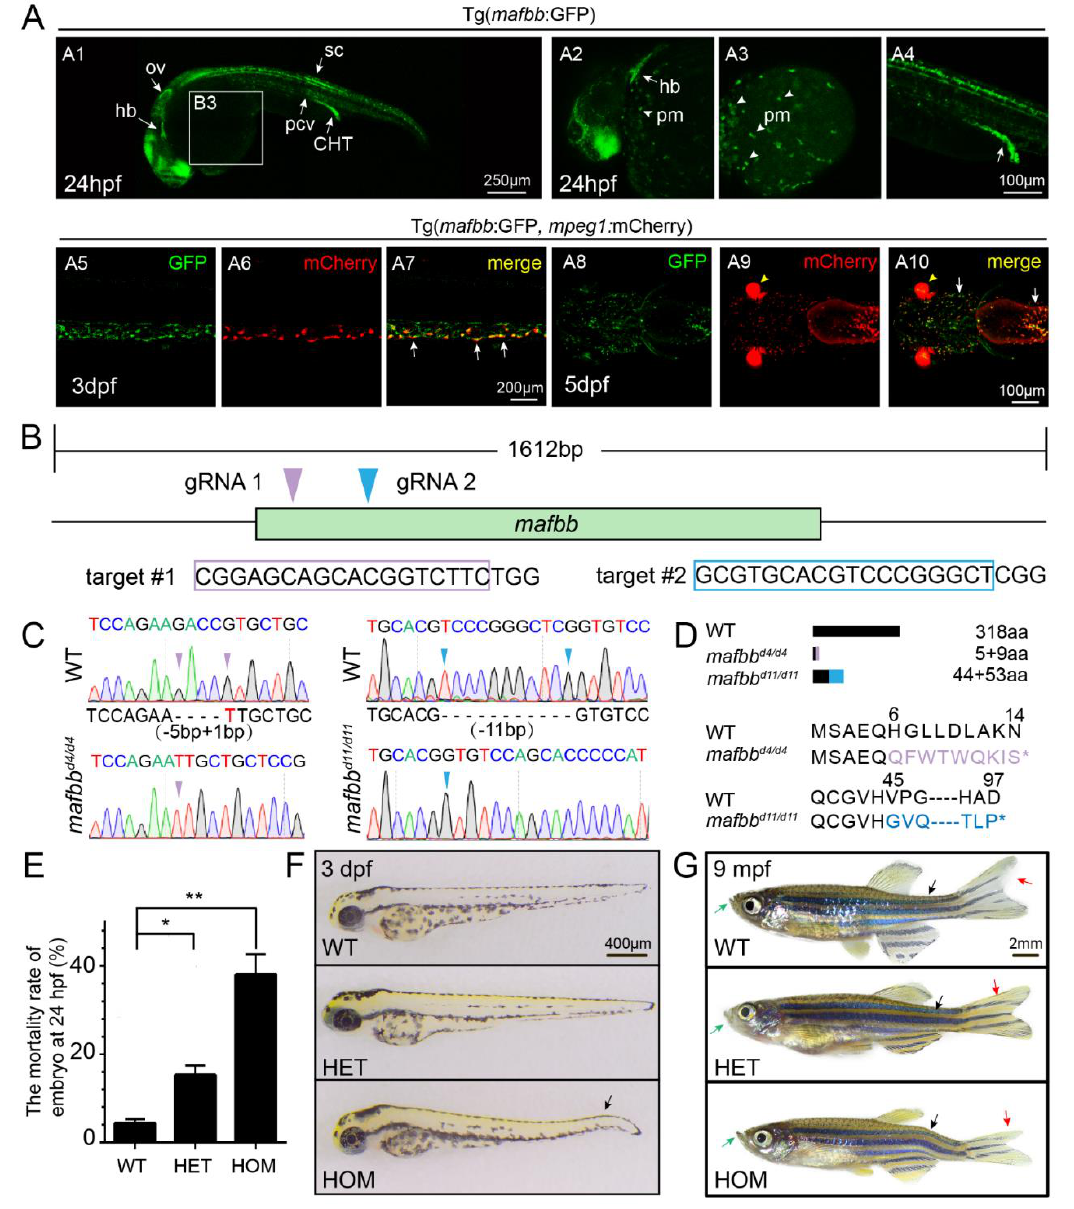
Figure 1. The expression of mafbb during embryogenesis and generation of mafbb mutants. ( A ) Tg ( mafbb :GFP) shows mafbb expression in primitive myeloid (pm) cells, hindbrain (hb), otic vesicle (ov), spinal cord (sc), posterior cardinal vein (pcv), caudal hematopoietic tail region (CHT) (A1–4). A2–4 are enlarged images of A1. The white arrowheads in A2 and A3 point to pm cells. The double Tg( mafbb :GFP; mpeg1 :mCherry) shows the expression of GFP in mCherry + -macrophages in the CHT (A5–7, lateral views) and in the head region (A8–10, ventral views). The white arrows in (A7 and A10) point to the overlapped expression of mafbb and mepg1 . The arrowheads in (A9–10) mark the eyes from -crystallin-mCherry in the plasmid of mabb :GFP [32]. ( B ) The schematic diagram of mafbb cDNA and the targeted regions of two guide RNAs. The target DNA sequences are shown in purple or blue rectangles. ( C ) Sanger sequencing analysis of PCR fragments containing gRNA1 and gRNA2 targeted regions from mafbb deficient homozygotes. The deleted nucleotides are replaced by -, and the inserted nucleotides are in red. ( D ) Schematic representation and amino acid sequence of the wild type MafBb and two predicted truncated proteins. ( E ) The mortality rate of embryos at 24 hpf (n = 315–688 per group). Results are expressed as mean ± SEM, (* p < 0.05, ** p < 0.01, t test). The statistical significance was displayed as ( F ) Images of embryos at 3 dpf. The black arrow points to the curved tail. ( G ) Images of adult zebrafish at 9 mpf. The projecting lower jaw (green arrows), the curved spine (black arrows) and the asymmetric caudal fin (red arrows) are shown in mafbb −/− mutants. WT, wild type; HET, mafbb d 11 /+ ; HOM, mafbb d 11 /d 11 ; mpf, month post fertilization.